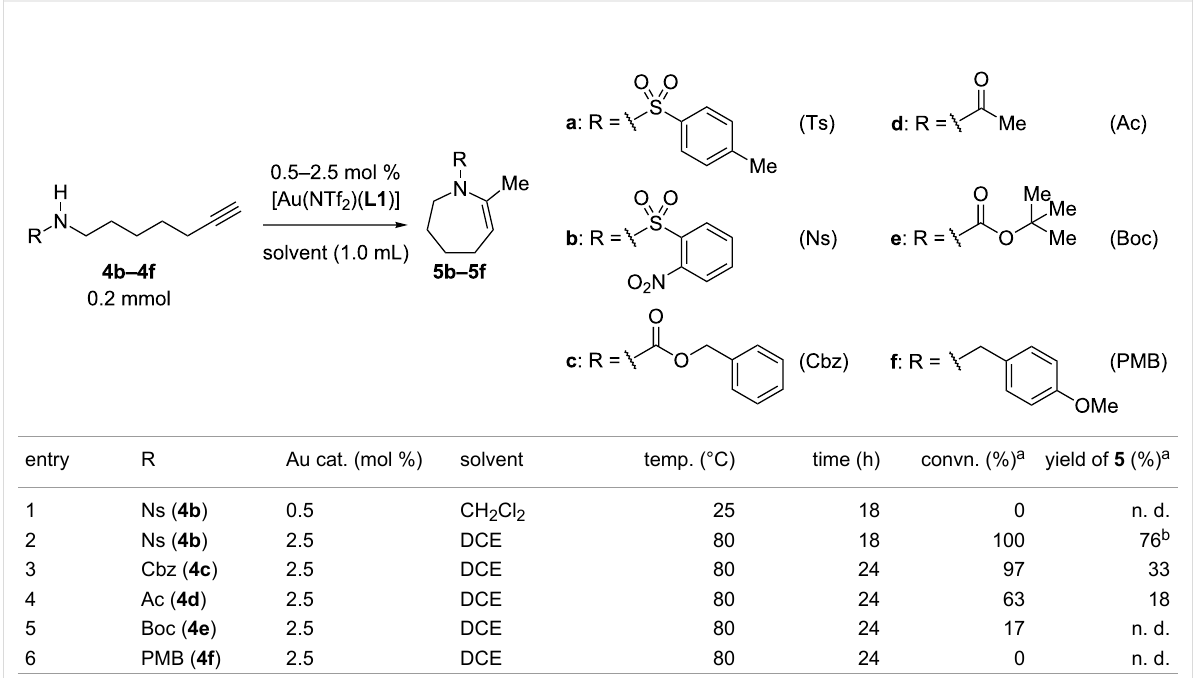
Table 2: Effect of N-substitutents.